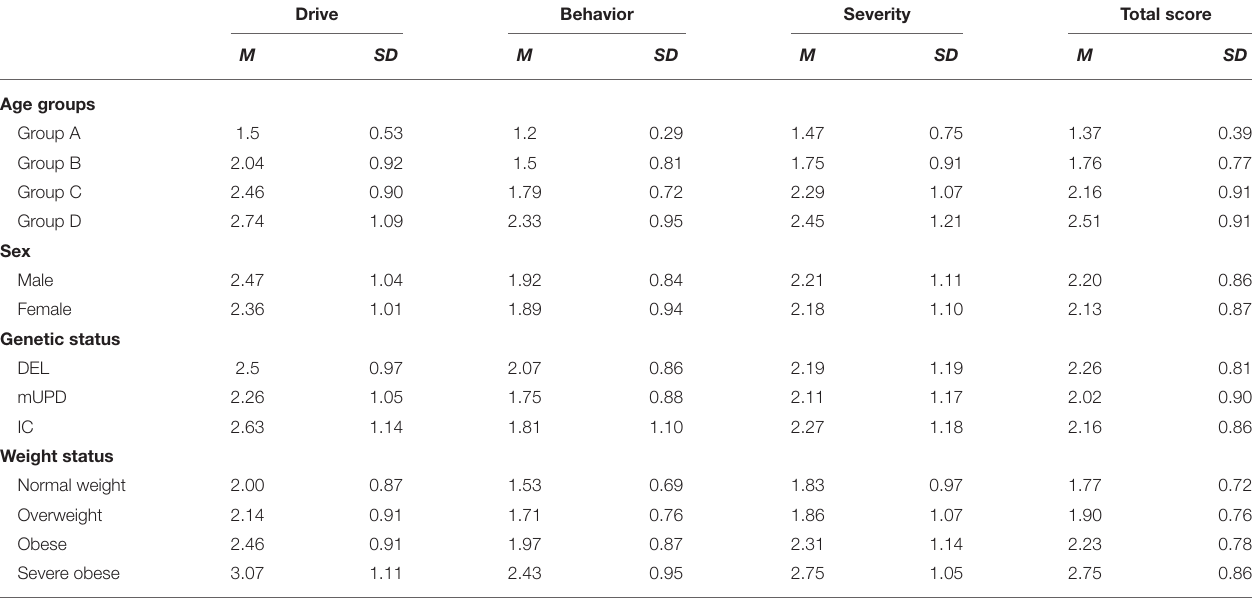
TABLE 4 | Means and standard deviation of hyperphagic dimensions and total score by age groups, sex, genetic status, and weight status. Drive Behavior